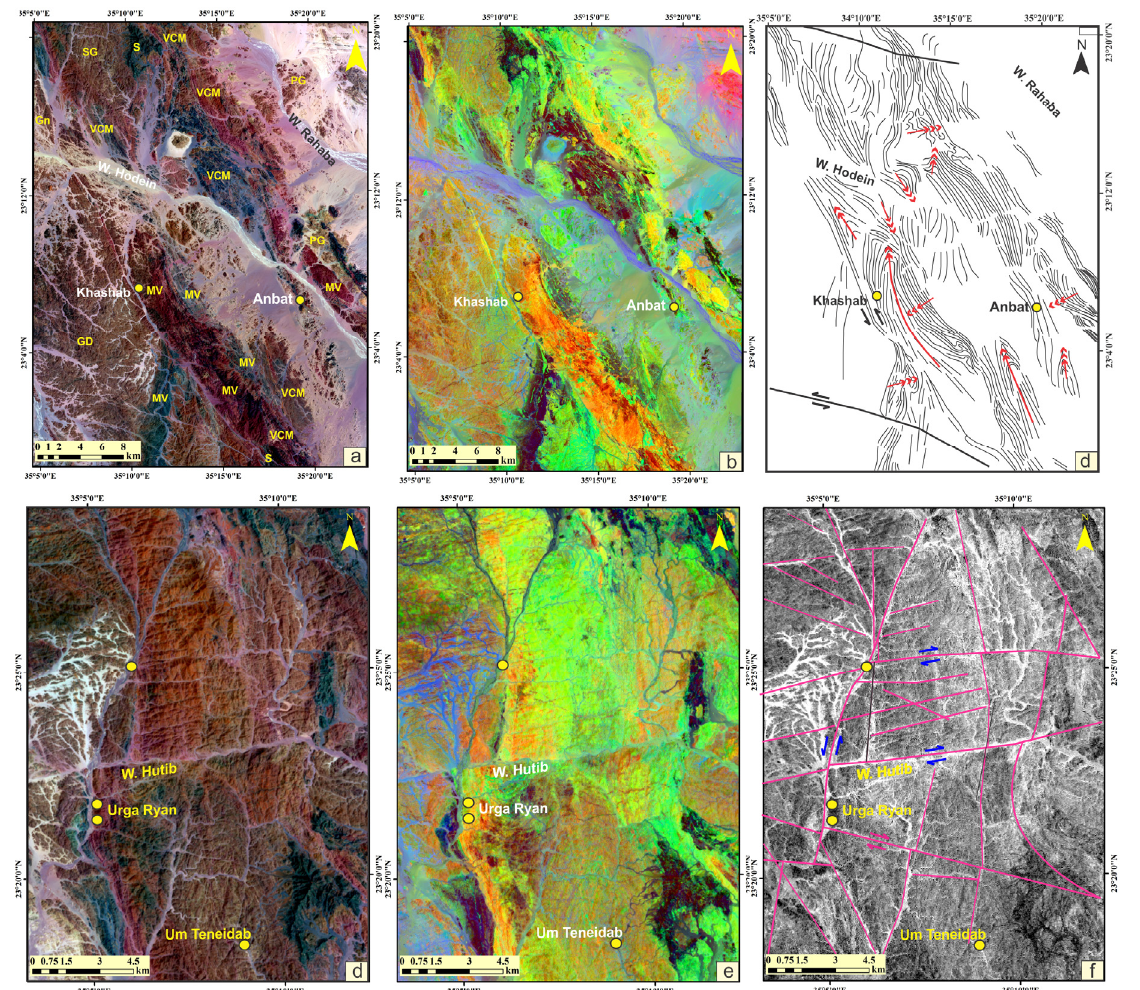
Figure 12. ( a , d ) Landsat-8 OLI band composites RGB-753, ( b , e ) Landsat-8 OLI band ratio RGB-7/6, 6/5, 4/2 highlighted ENE–WSW strike slip faults dissected the island arc metavolcanics, ( c ) the resultant interpretation maps of the different fold generations (thin lines for foliation trajectories and red arrows lines are interpreted fold axial traces and major faults (black lines) and ( f ) Landsat-8 PC3 shows the ENE–WSW dextral strike–slip faults cutting across pre-existing structures and controlling the drainage system. S; serpentinites, VCM; volcaniclastic metasediments, MV; metavolcanics, SG; syn-orogenic granites, GD; metagabbro–diorite complex, PG, post-tectonic granite.